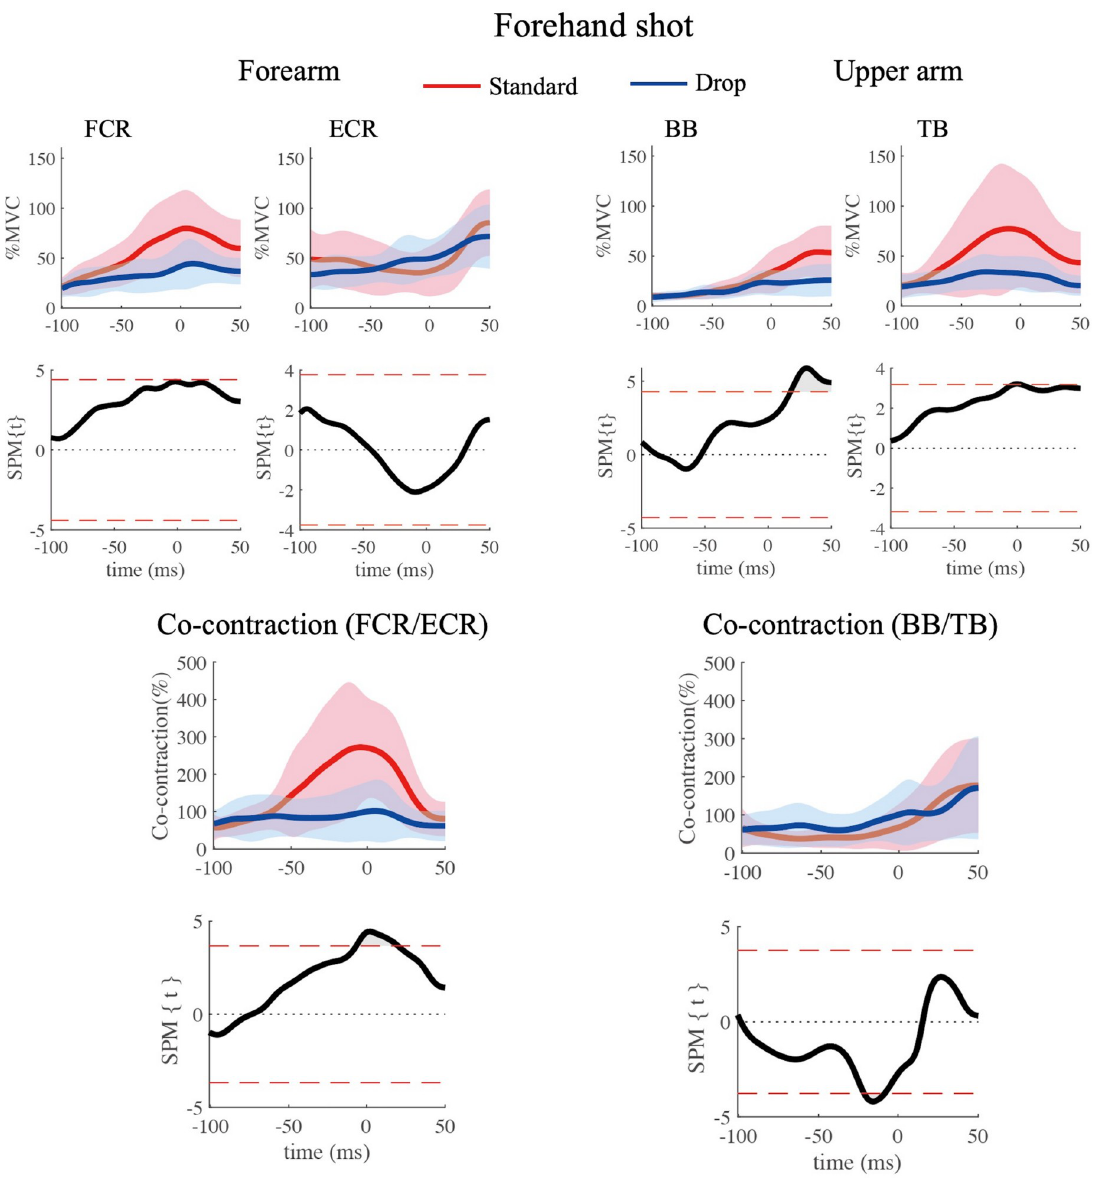
Fig 7. Four muscle activity; comparing the standard volley (red lines) and the drop volley (blue lines) for the forehand shot. Averaged time series data arw presented with corresponding results of the SPM analysis. Gray areas indicate the times when SPM{t} values exceeded the alpha level threshold, which is displayed as red dash lines. Time 0 depicts the time of impact.